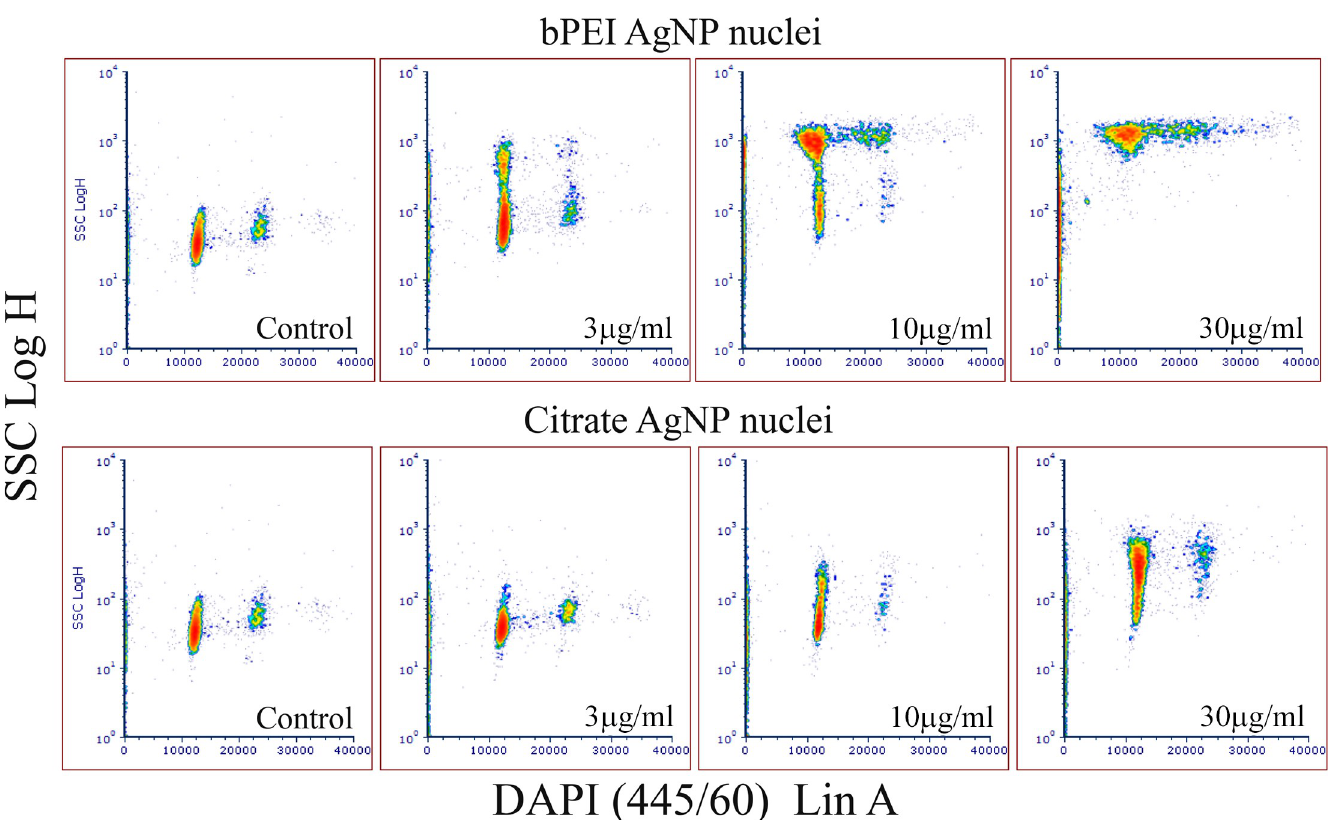
Fig 5. Flow cytometry cytograms of nuclei treated with AgNP-bPEI and AgNP-CIT. Flow cytometry comparison of DAPI stained nuclei derived from cells treated with AgNP-bPEI or AgNP-CIT at doses between 1 μ g/ml and 30 μ g/ml. Each successive higher dose resulted in greater amount of side scatter. This was presumably due to higher uptake of AgNP as shown in the cell scatter data (Figs 1 and 2) and the lack of complete cell lysis at all doses.